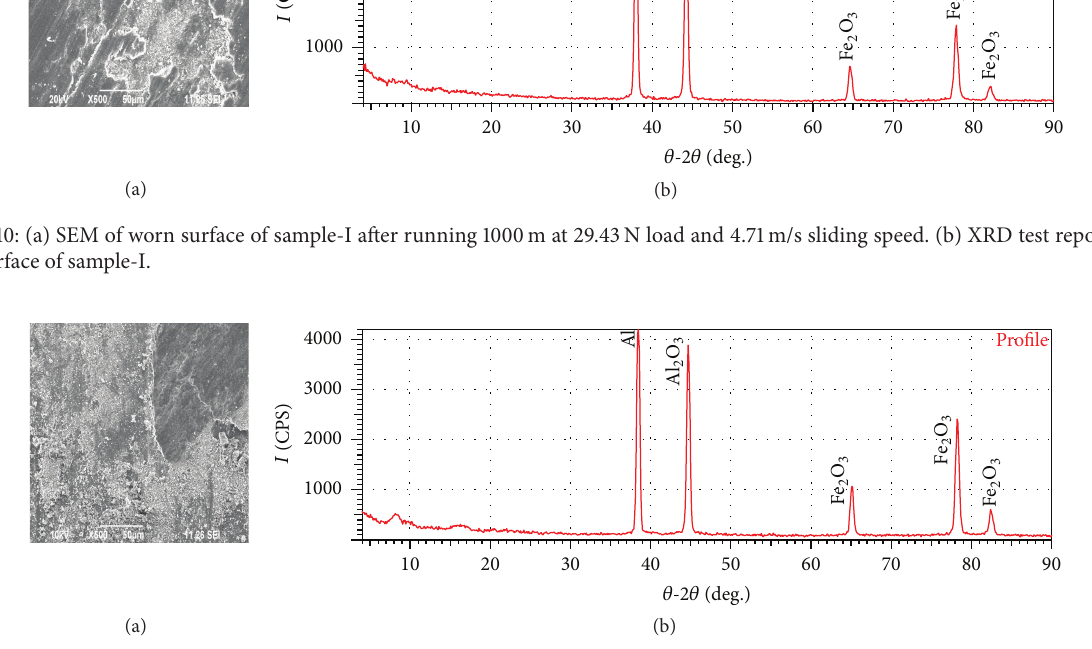
Figure 11: (a) SEM of worn surface of sample-II after running 2000 m at 29.43 N load and 4.71m/s sliding speed. (b) XRD test report of the worn surface of